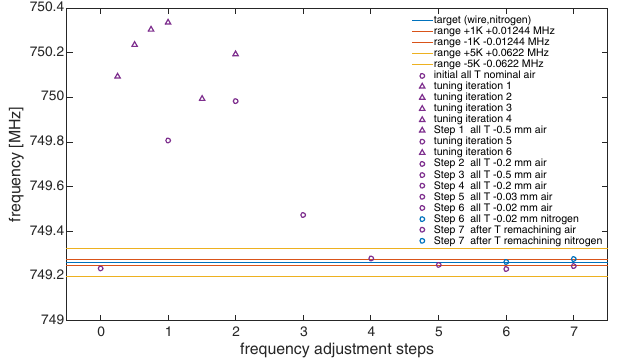
FIG. 16. The plot shows the different frequency adjustment steps that were made until the target frequency was approached.